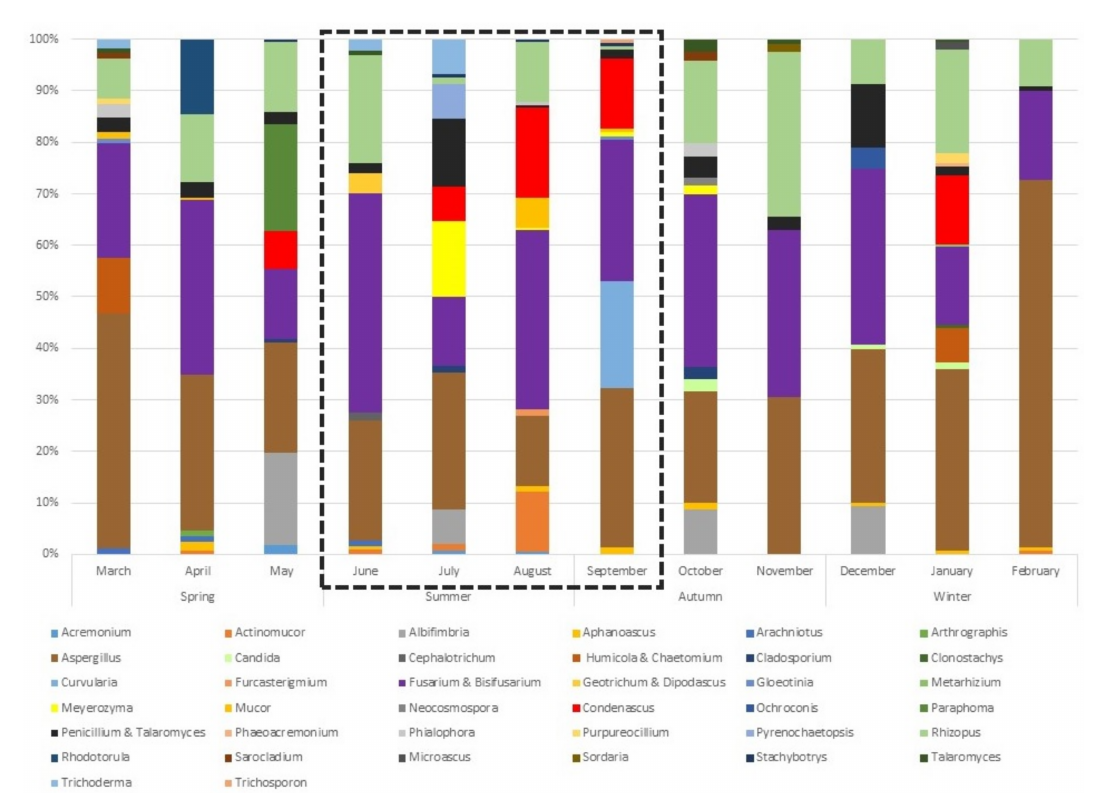
Figure 1. Relative abundance of cultured fungal genera (in %) in the samples taken each month during the period of 12 months. The official bathing season is indicated with black dashed